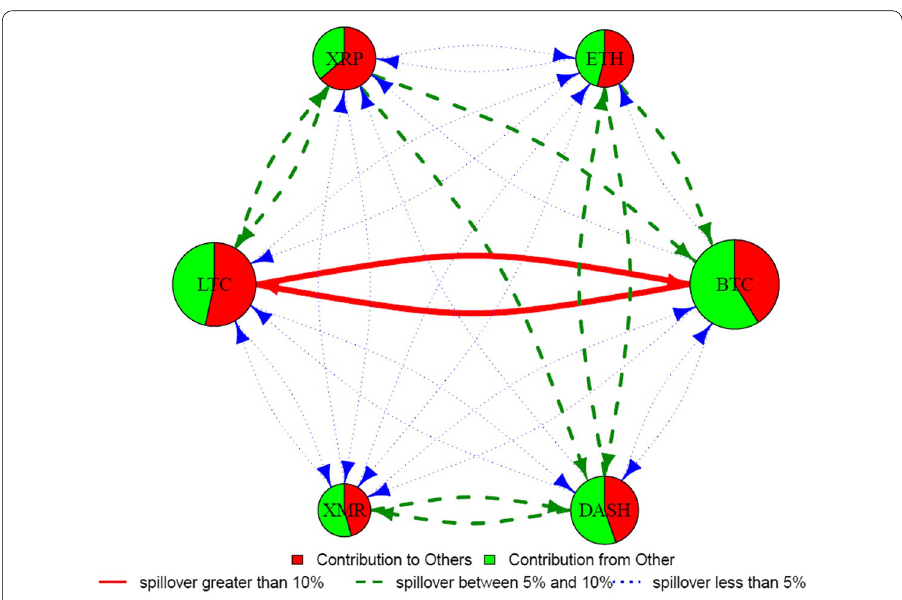
Fig. 1 Spillover diagram using DY approach. Note : This network graph illustrates the degree of total connectedness in a system that consists of the six cryptocurrencies over the full sample period. Total connectedness is measured using the Diebold-Yilmaz framework. The size of the node shows the magnitude of contribution of each variable to system connectedness, while the color indicates the origin of connectedness. In particular, the red color implies contribution from the variable under consideration to the other variables of the system and the green color means contribution from the other variables to the variable under analysis. The color and shape of the arrows refer to the strength of connectedness. The red colour and full line arrows represent strong spillovers while green and blue colour arrows show medium and weak liquidity spillovers,